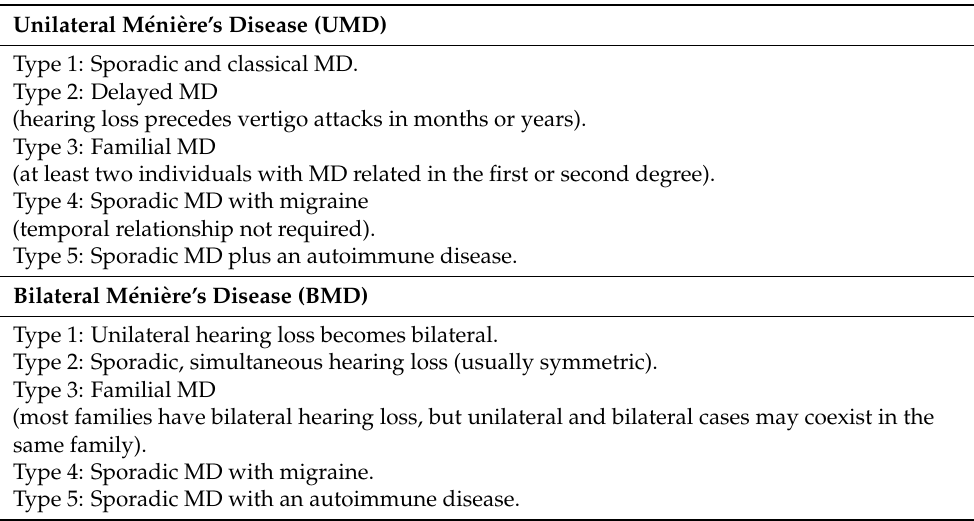
Table 1. Clinical subgroups of patients with unilateral and bilateral Meniere disease. Modified from Frejo et al.